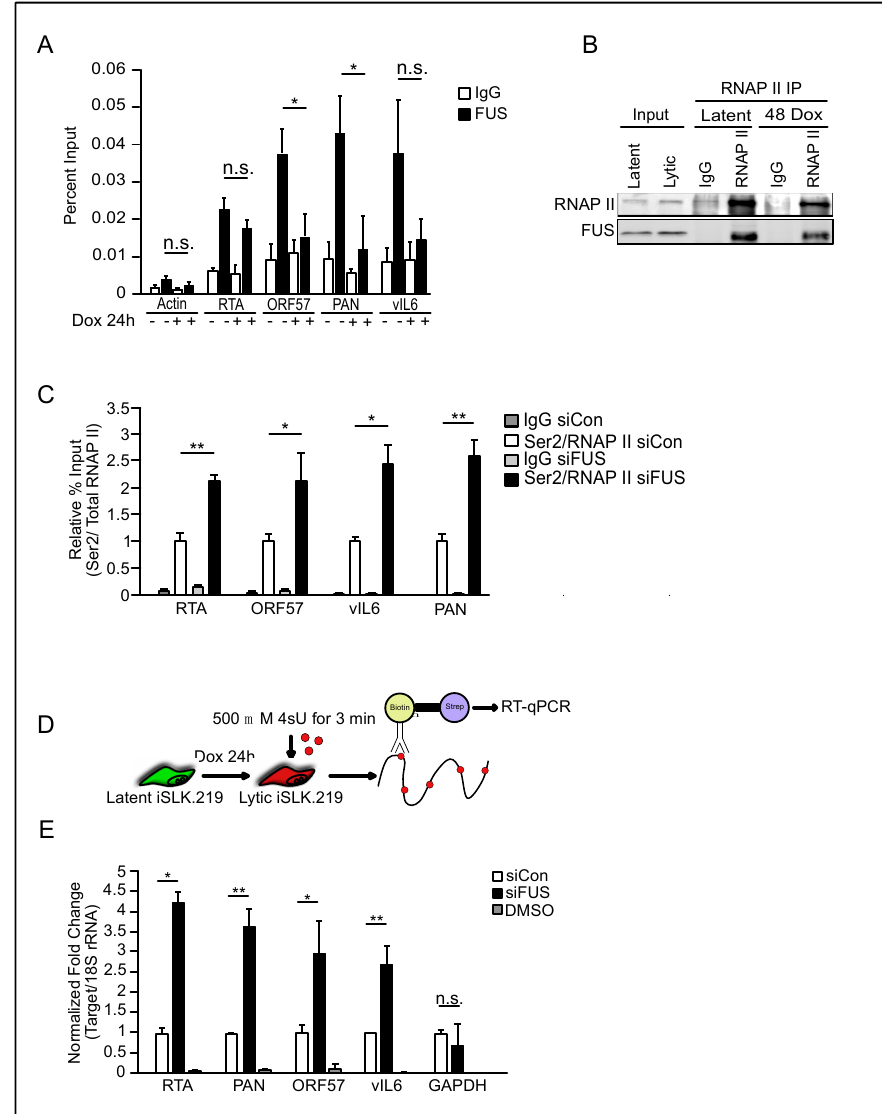
Figure 7. FUS regulates RTA nascent RNA expression. ( A ) FUS occupancy of the indicated viral genes was analyzed by Chromatin immunoprecipitation (ChIP) in iSLK.219 cells 24 h post-reactivation. IgG was used as a negative control. ( B ) Western blot of RNAP II immunoprecipitation (IP) from iSLK.219 cells at latency and 48 h post-reactivation. ( C ) Ser2 RNAP II occupancy was determined at the indicated viral genes by ChIP 48 h post-reactivation in iSLK.219 cells treated with either siCon or siFUS. Ser2 levels were normalized to total RNAP II present at each genomic loci as determined by ChIP. siCon ratio set at 1. ( D ) Schematic representation of the assay employed to measure nascent RNA synthesis. Cells are labeled with 500 mM 4sU for 3 min prior to total RNA isolation. Labeled RNA is subjected to thiol-specific biotinylation, followed by streptavidin purification and RT-qPCR. ( E ) RT-qPCR of nascent viral and host transcripts. Values were normalized to 18S. DMSO was added in place of 4sU as a negative control. Student t test used to determine statistical significance * p ≤ 0.05. ** p ≤ 0.005, n.s. not significant.